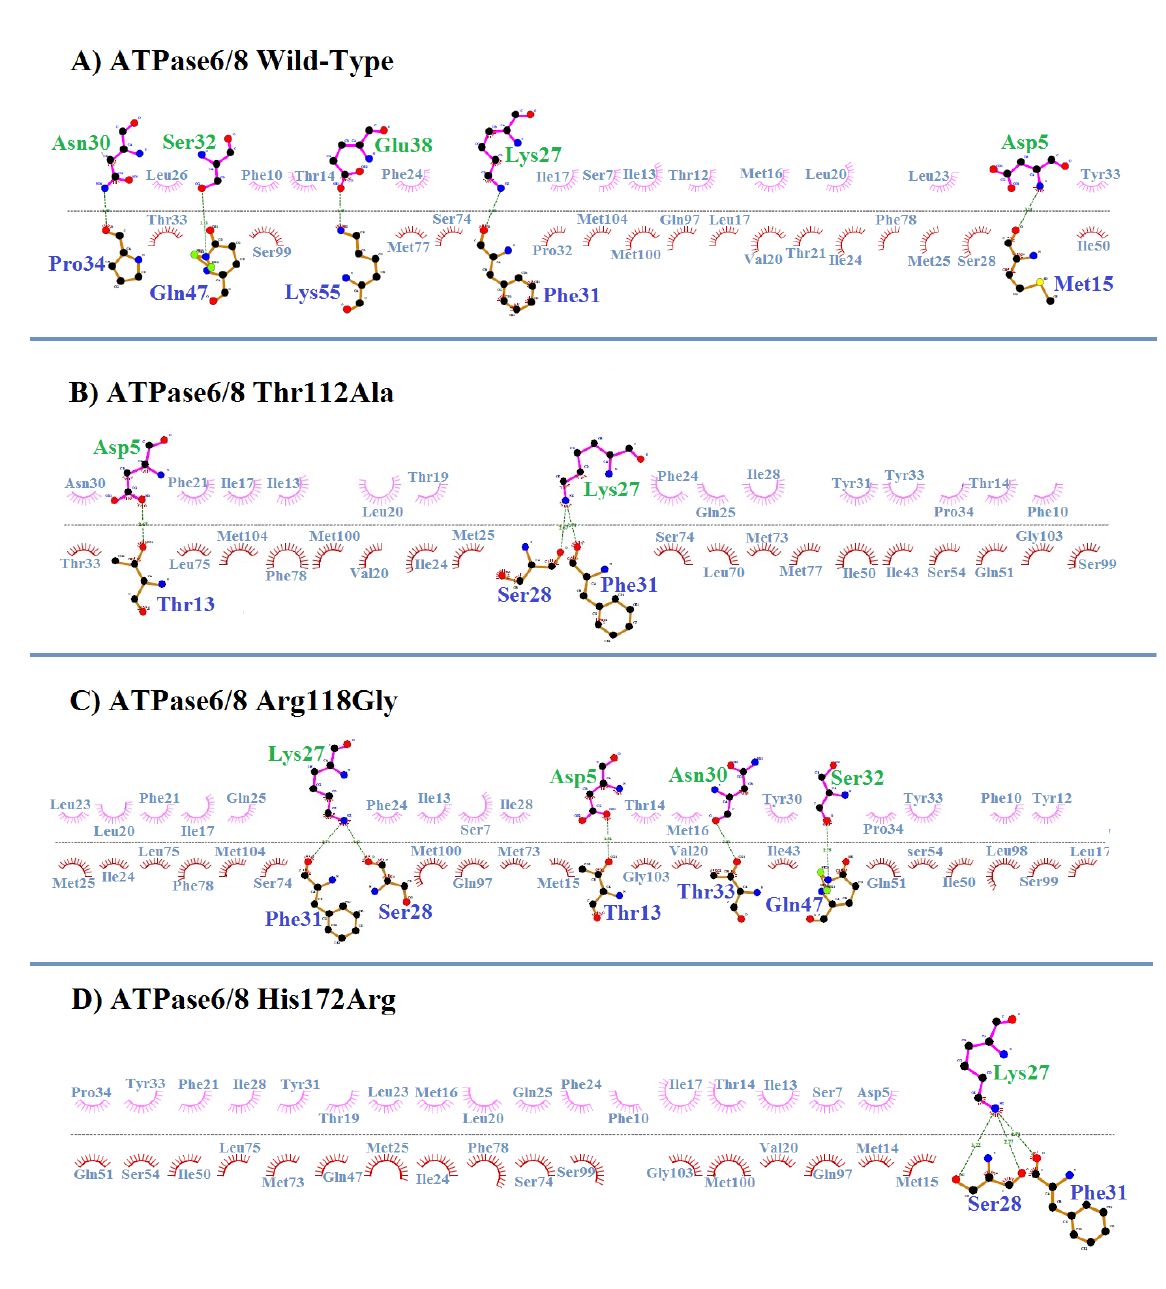
Figure 9: A-D ) Comparison of hydrogen bonding patterns and hydrophobic interaction patterns between wild-type and mutant states in ATPase6 by structural and molecular docking between ATPase6 and ATPase8 amino acids. Hydrogen bonds are shown by dashed lines (green) between wild-type and mutant states of ATPase6 (upper line) with ATPase8 (bottom line) residues and hydro- phobic interactions are indicated by feathered arcs between